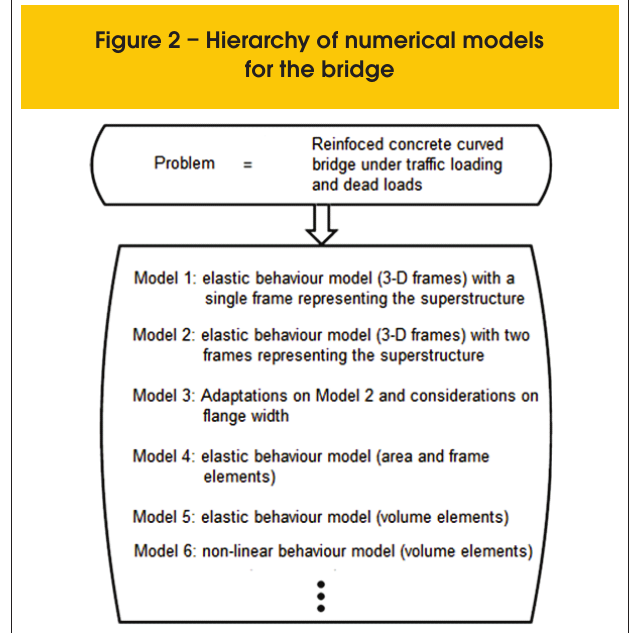
Figure 2 – Hierarchy of numerical models for the